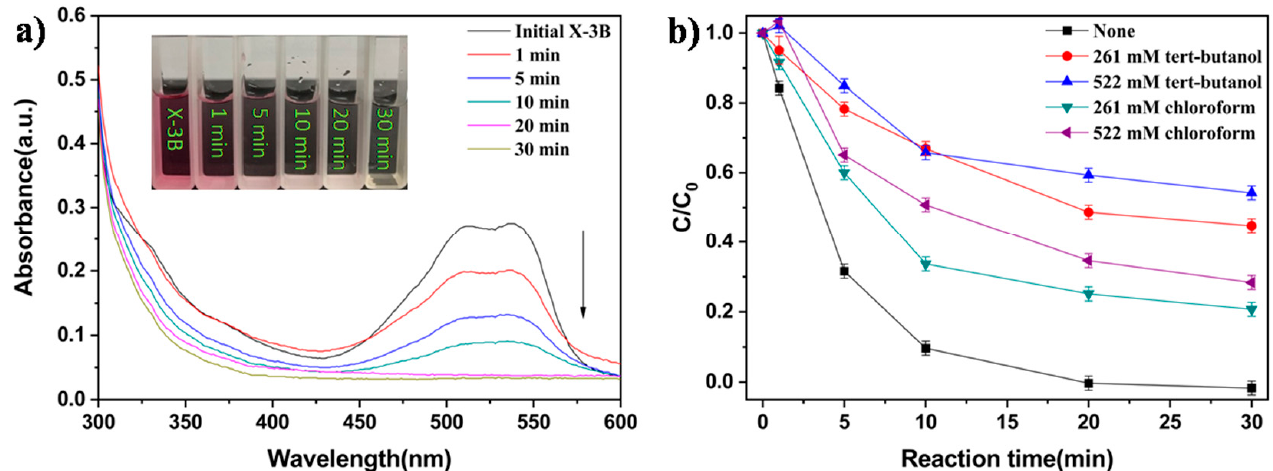
Figure 6. ( a ) UV-Vis spectroscopy and color change (inset) in X-3B for different reaction periods; ( b ) quenching effects of tert-butanol and chloroform on the removal of X-3B in the MAER UV–Fenton system. Reaction conditions: C 0, X-3B = 50 mg/L, [Material] = 0.25 g/L, [H 2 O 2 ] = 150 mM, T = 25 °C, and pH with no adjustment.